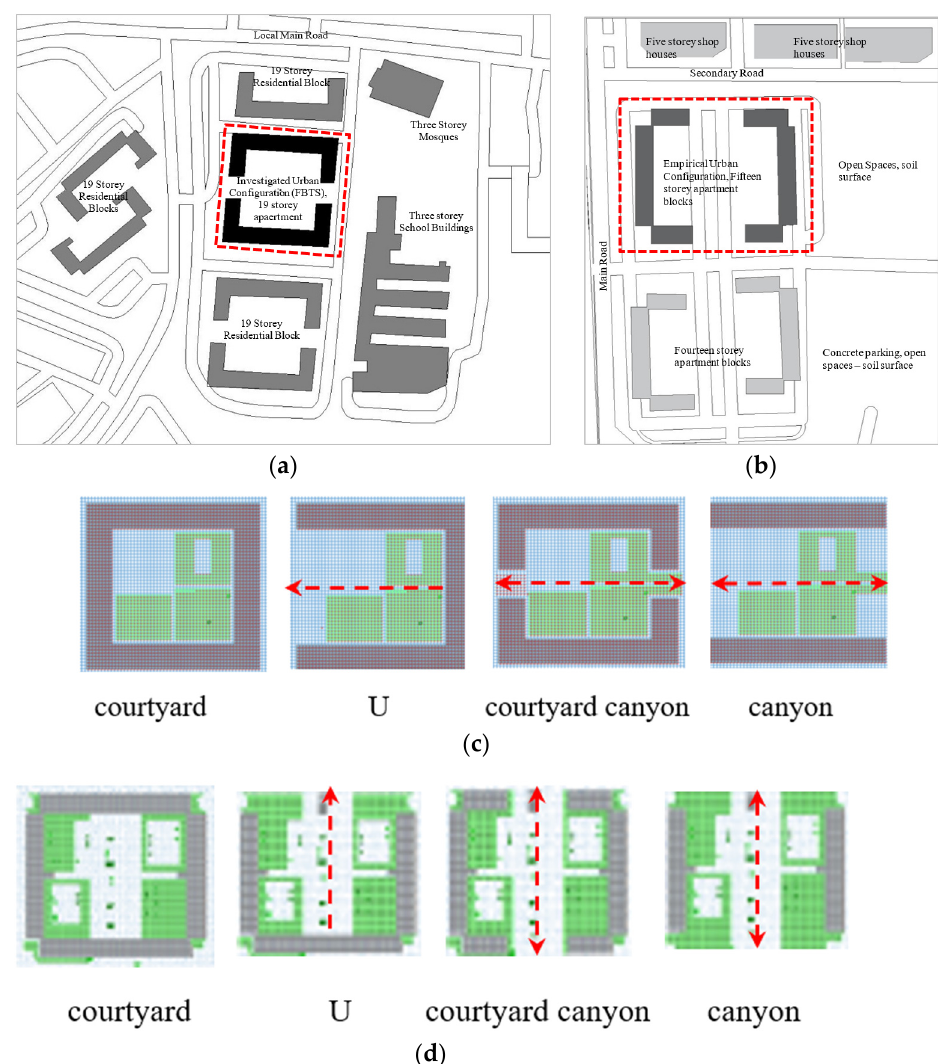
Figure 1. The site map with the existing configuration and surrounding situation of FBTS ( a ) and SM ( b ), and the target area of ENVI-met urban configuration simulation at both sites—FBTS ( c ) and SM ( d ). The red arrows show the canyon direction parallel and perpendicular to the path of the Sun.